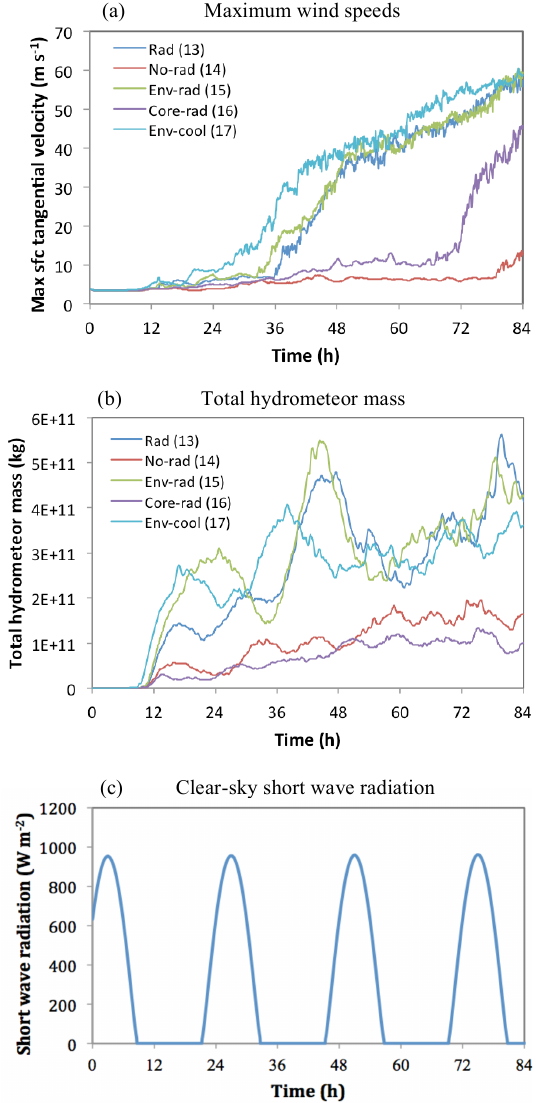
Figure 23. Time series for Experiments 13–17: (a) maximum az- imuthally averaged tangential wind speeds at z = 29 . 5m (ms − 1 ), (b) total hydrometeor mass in the domain (kg), and (c) clear-sky short wave radiation at the surface (Wm − 1